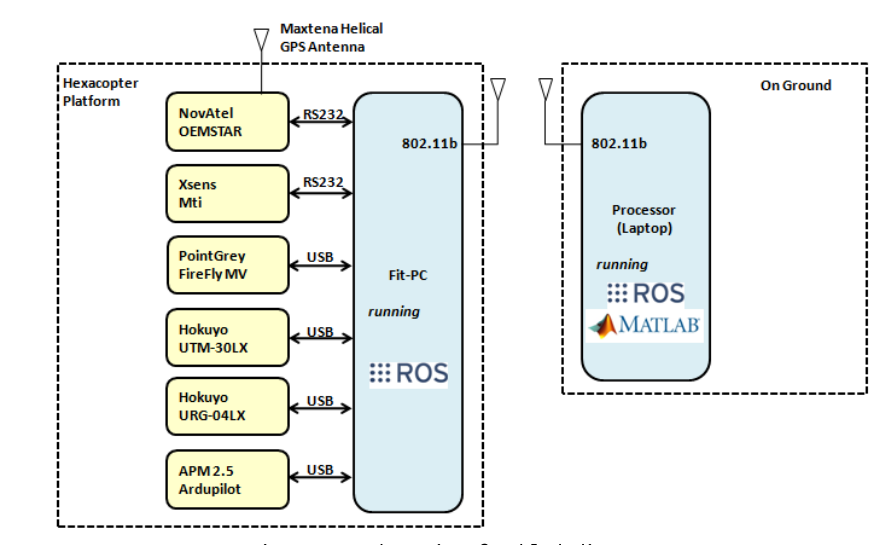
Figure 5. Hardware interface block